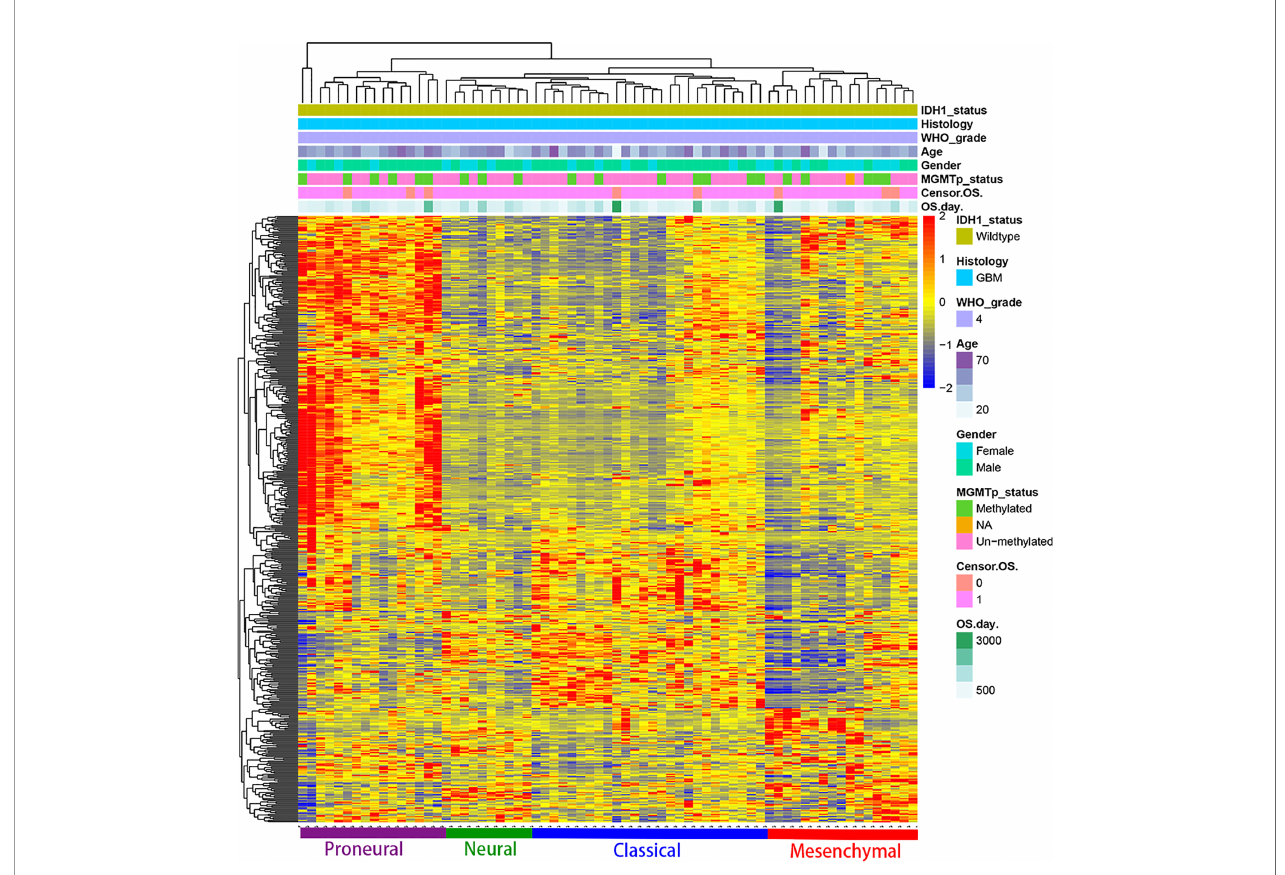
FIGURE 5 | Supervised cluster analysis of gene expression in GBM patients shows it suits the Verhaak ’ s classes